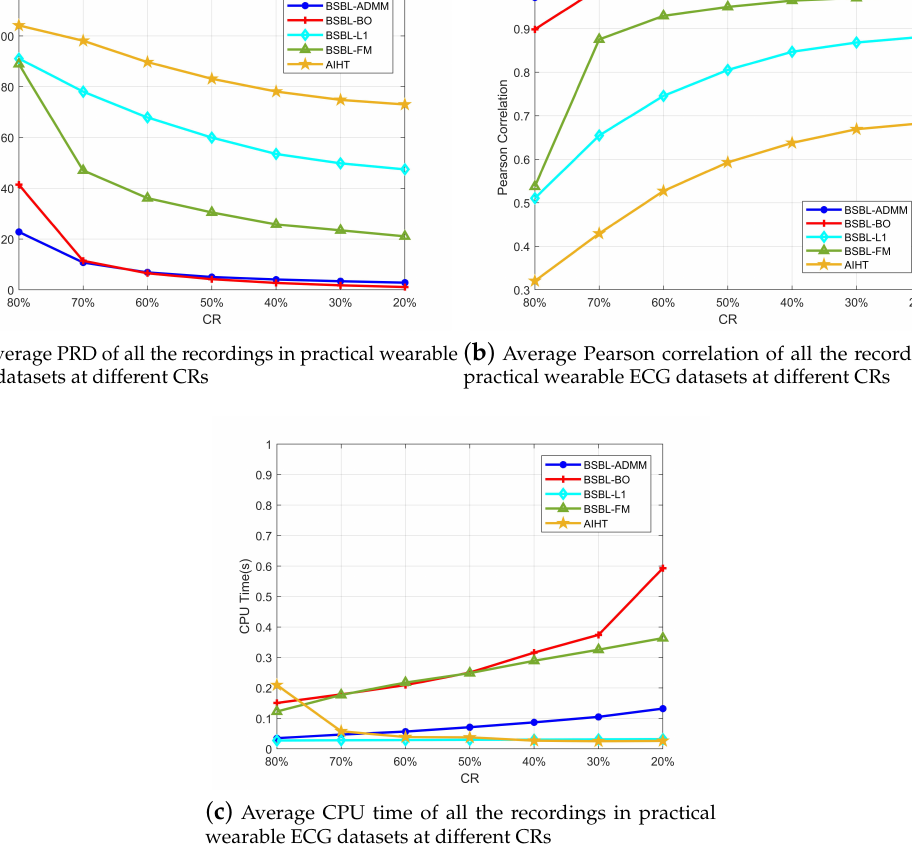
Figure 7. Recovery results of all the recordings in practical wearable ECG datasets at different CRs (compression ratios). ( a , b ) show that the PRD (percentage root-mean squared distortion) and Pearson correlation of BSBL-ADMM is very close to BSBL-BO, the other two have much worse recovery accuracy; ( c ) shows that the BSBL-ADMM has much faster speed compared with BSBL-BO. These results on practical wearable ECG datasets demonstrate that the proposed BSBL-ADMM algorithm has both satisfactory speed and accuracy compared with the other